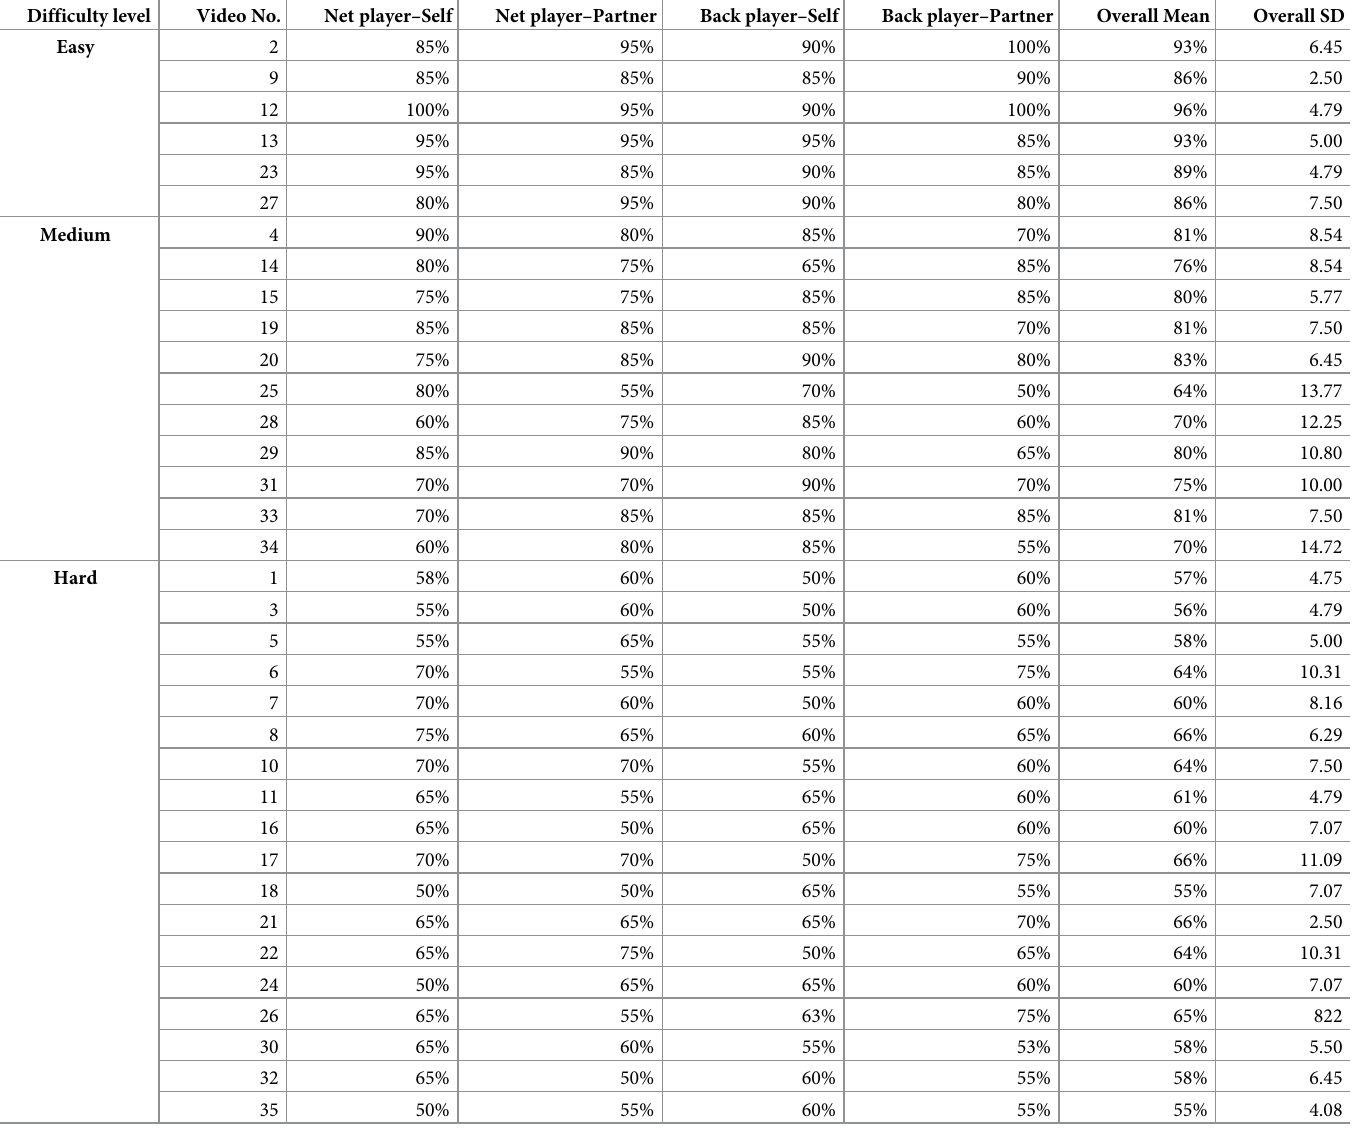
Table 1. Percentage agreement for all conditions on all videos. Difficulty level Video